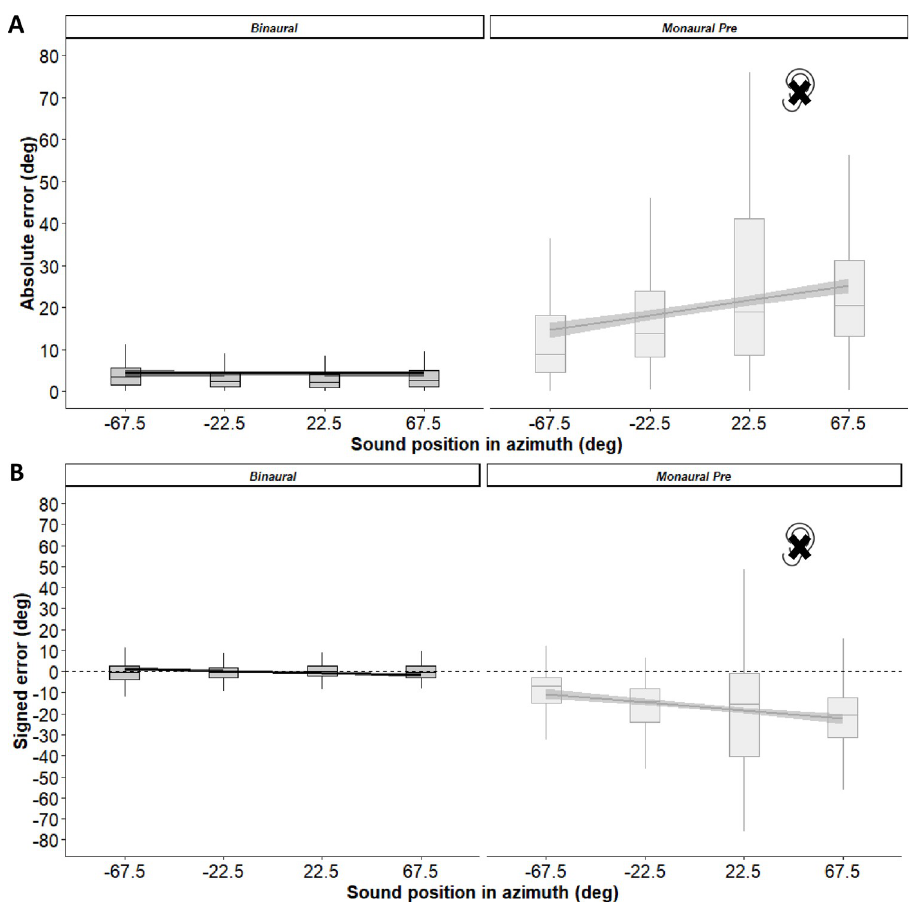
Fig 2. Head-pointing sound localization in session 1 before training. (A) Absolute error and (B) signed error, as a function of sound position in azimuth and listening condition. Dashed lines indicate the 95% confidence intervals